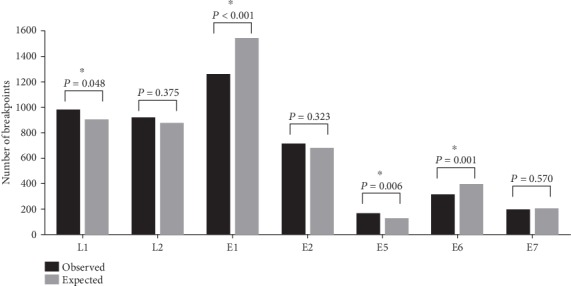
Comparison of the observed and expected numbers of breakpoints in HPV16 genome.